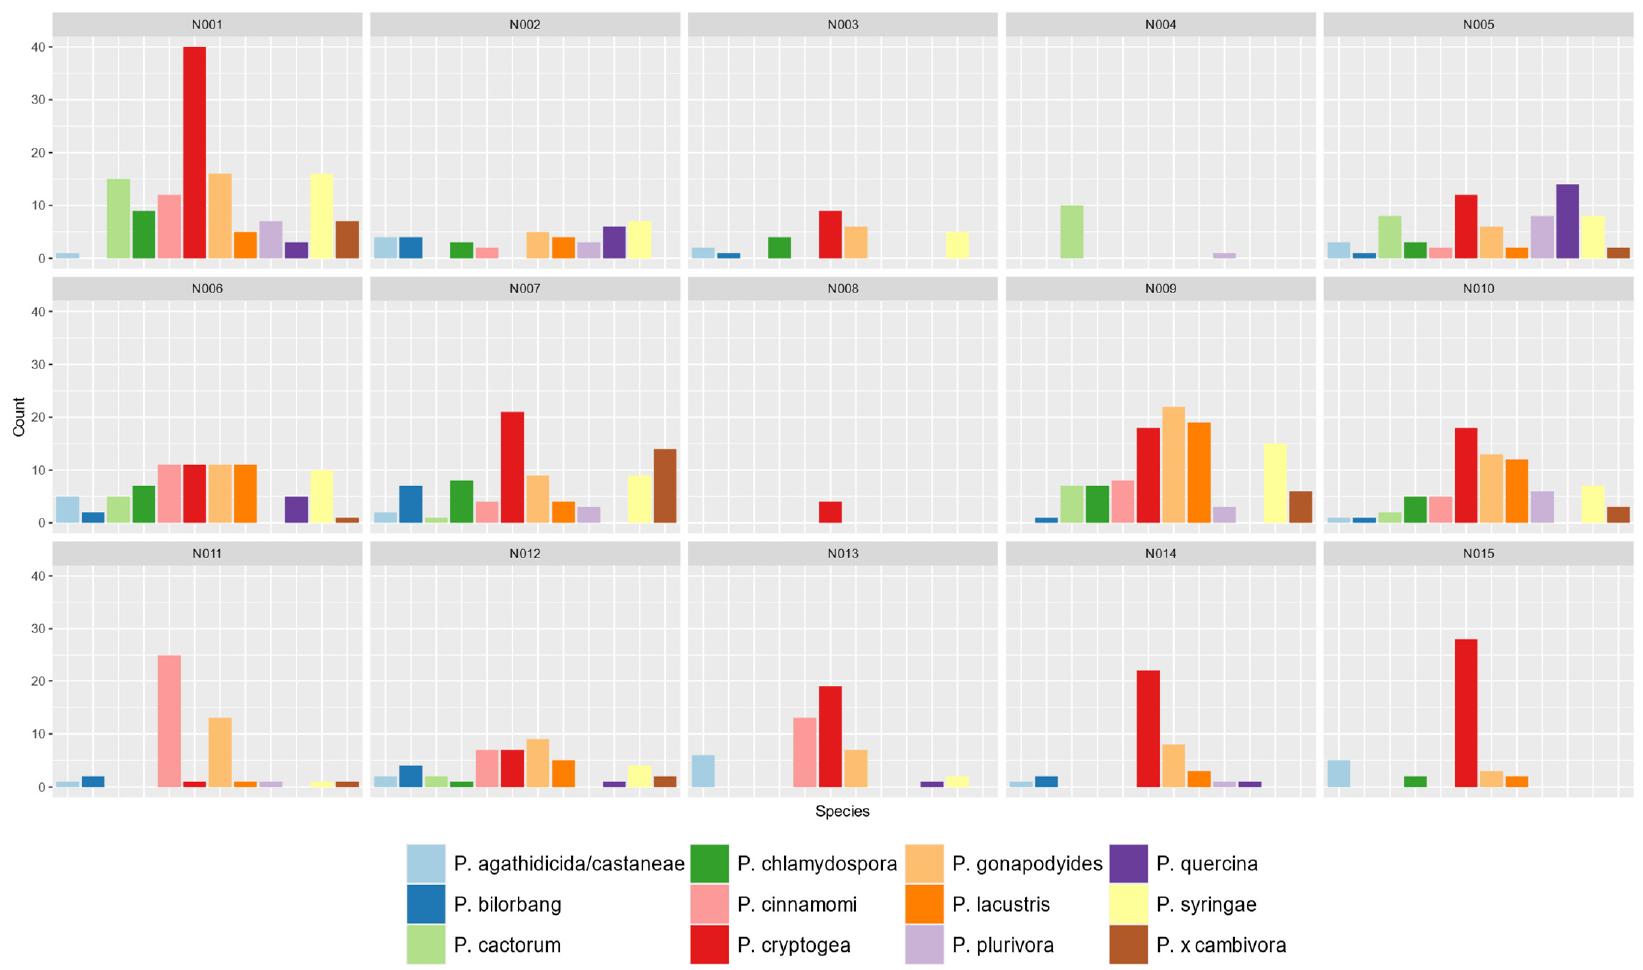
Figure 5. Abundance (by number of samples) of the 12 Phytophthora species most frequently detected in the fifteen partner nurseries (N001-N015) in the fine-scale nursery survey. Note P. cryptogea values include those of P. pseudocryptogea . The clade 6 taxa (such as P. gonapodyides and P. lacustris ) are generally considered native and less pathogenic, and are abundant in rivers in Europe. However, the other abundant species (which, in addition to the above species, also included P. cactorum , P. cambivora , P. plurivora and P. nicotianae ) are common pathogens on many hosts in the nursery industry. The important quarantine-regulated species P. ramorum was found in twelve samples overall and P. kernoviae not found at all, whereas other regulated pathogens P. lateralis and P. austrocedri were each found in 10 samples. The relatively low abundance of P. ramorum and absence of P. kernoviae , both of which are heavily targeted in Plant Health surveillance, suggests that existing phytosanitary measures may be working to some extent. Other species of concern included P. cinnamomi which is adapted to warmer environmental conditions, has an exceptionally wide host range and was found to be widespread on a range of hosts particularly in nurseries in southern England. Phytophthora quercina was found in the majority of Quercus plants sampled in the survey. This species is thought to be native to Europe and implicated in root damage and progressive decline of